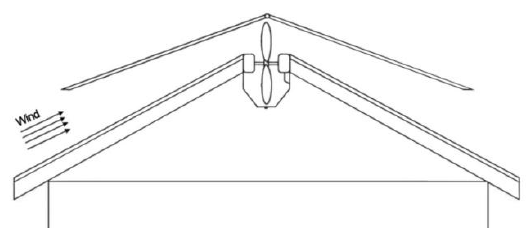
Figure 1. Wind energy conversion system for pitched roof. Reprint with permission [37]; 2012, United States Patent.